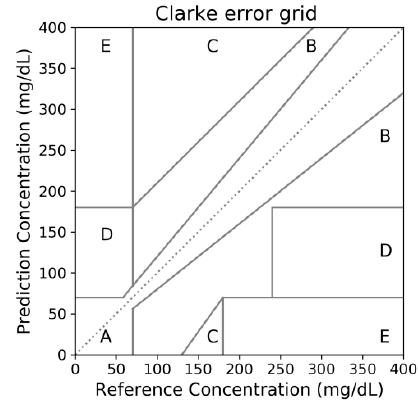
Figure 2. Zones on the Clarke error grid analysis. Figure 3. Zones on the Clarke error grid